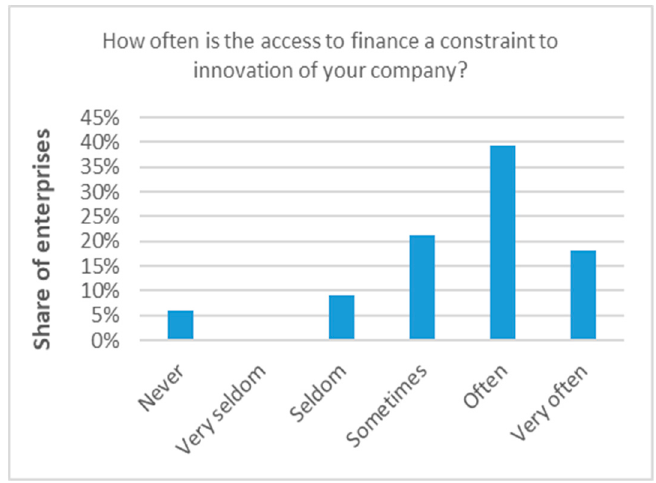
Figure 10. Financial barriers to innovation.